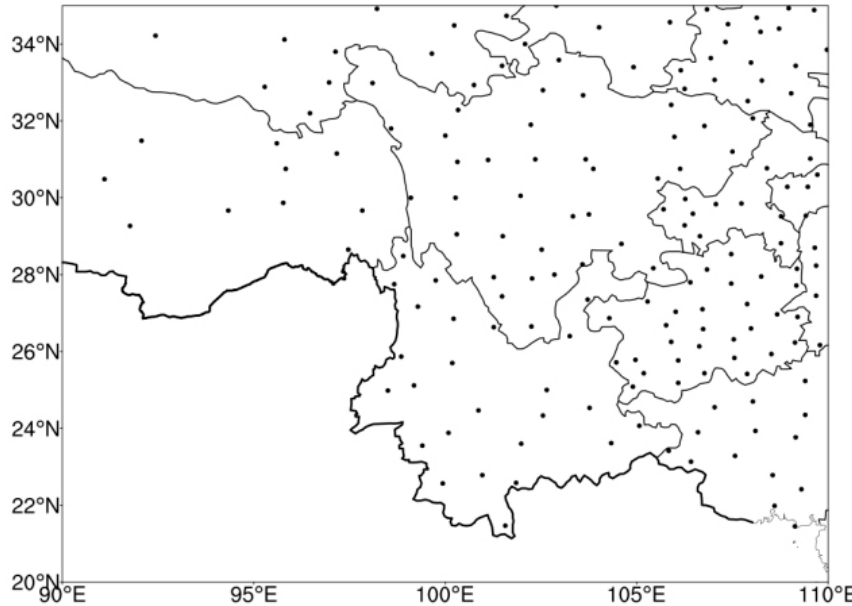
Figure 1. Location of the precipitation gauges in southwestern China, the data of which were used for the analysis. We select a monsoon index named the East Asian monsoon index ( I M ), which defines the day-by-day East Asian summer monsoon intensity [4]. Combined with kinetic and thermodynamic factors, this index links the different activity characteristics of the EASM in East Asian subtropical and tropical regions well, which can well reflect the physical nature of the EASM, and its expression is as follows: